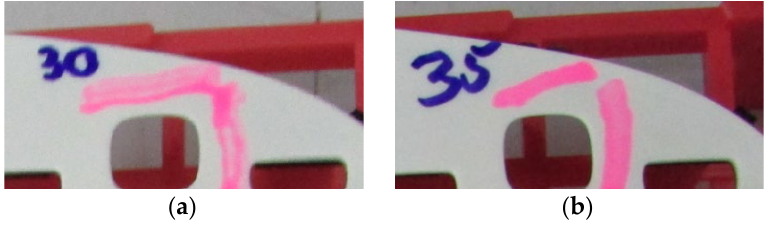
Figure 4. Surface tension value is ( a ) 30 mN/m for bad parts; ( b ) 35 mN/m for good parts.